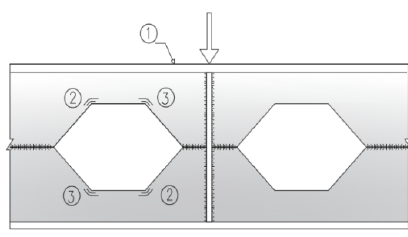
Figure 10: Failure mode of Specimen CCB-I